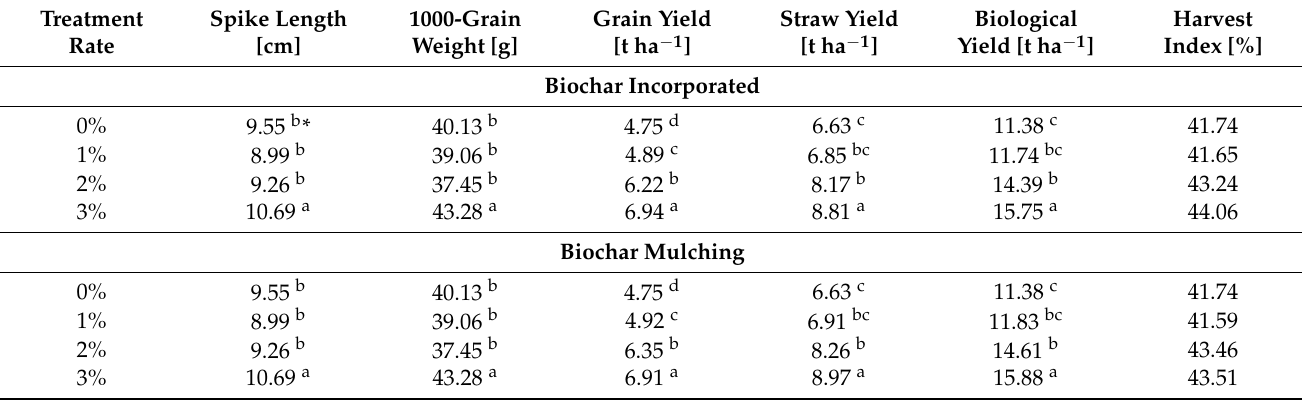
Table 4. Impacts of corncob biochar on wheat productivity and quality